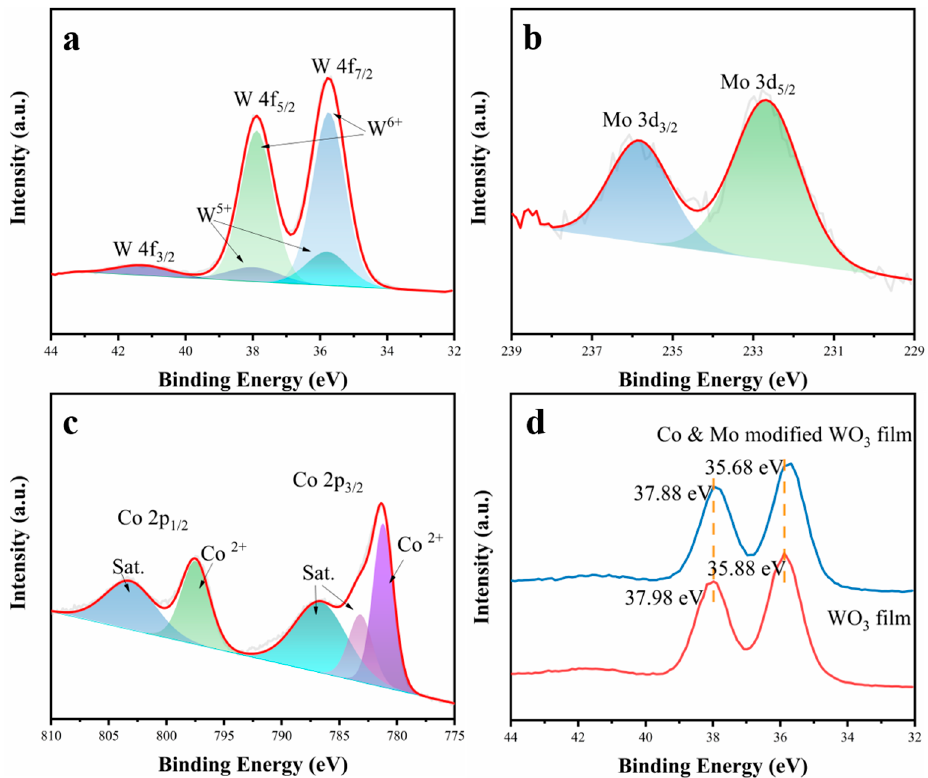
Figure 3. XPS spectra of WO 3 : Co, Mo film prepared by electrodeposition for 180 s. High-resolution of ( a ) W 4f, ( b ) Mo 3d, ( c ) Co 2p. ( d ) The difference between WO 3 : Co, Mo film and pure WO 3 film